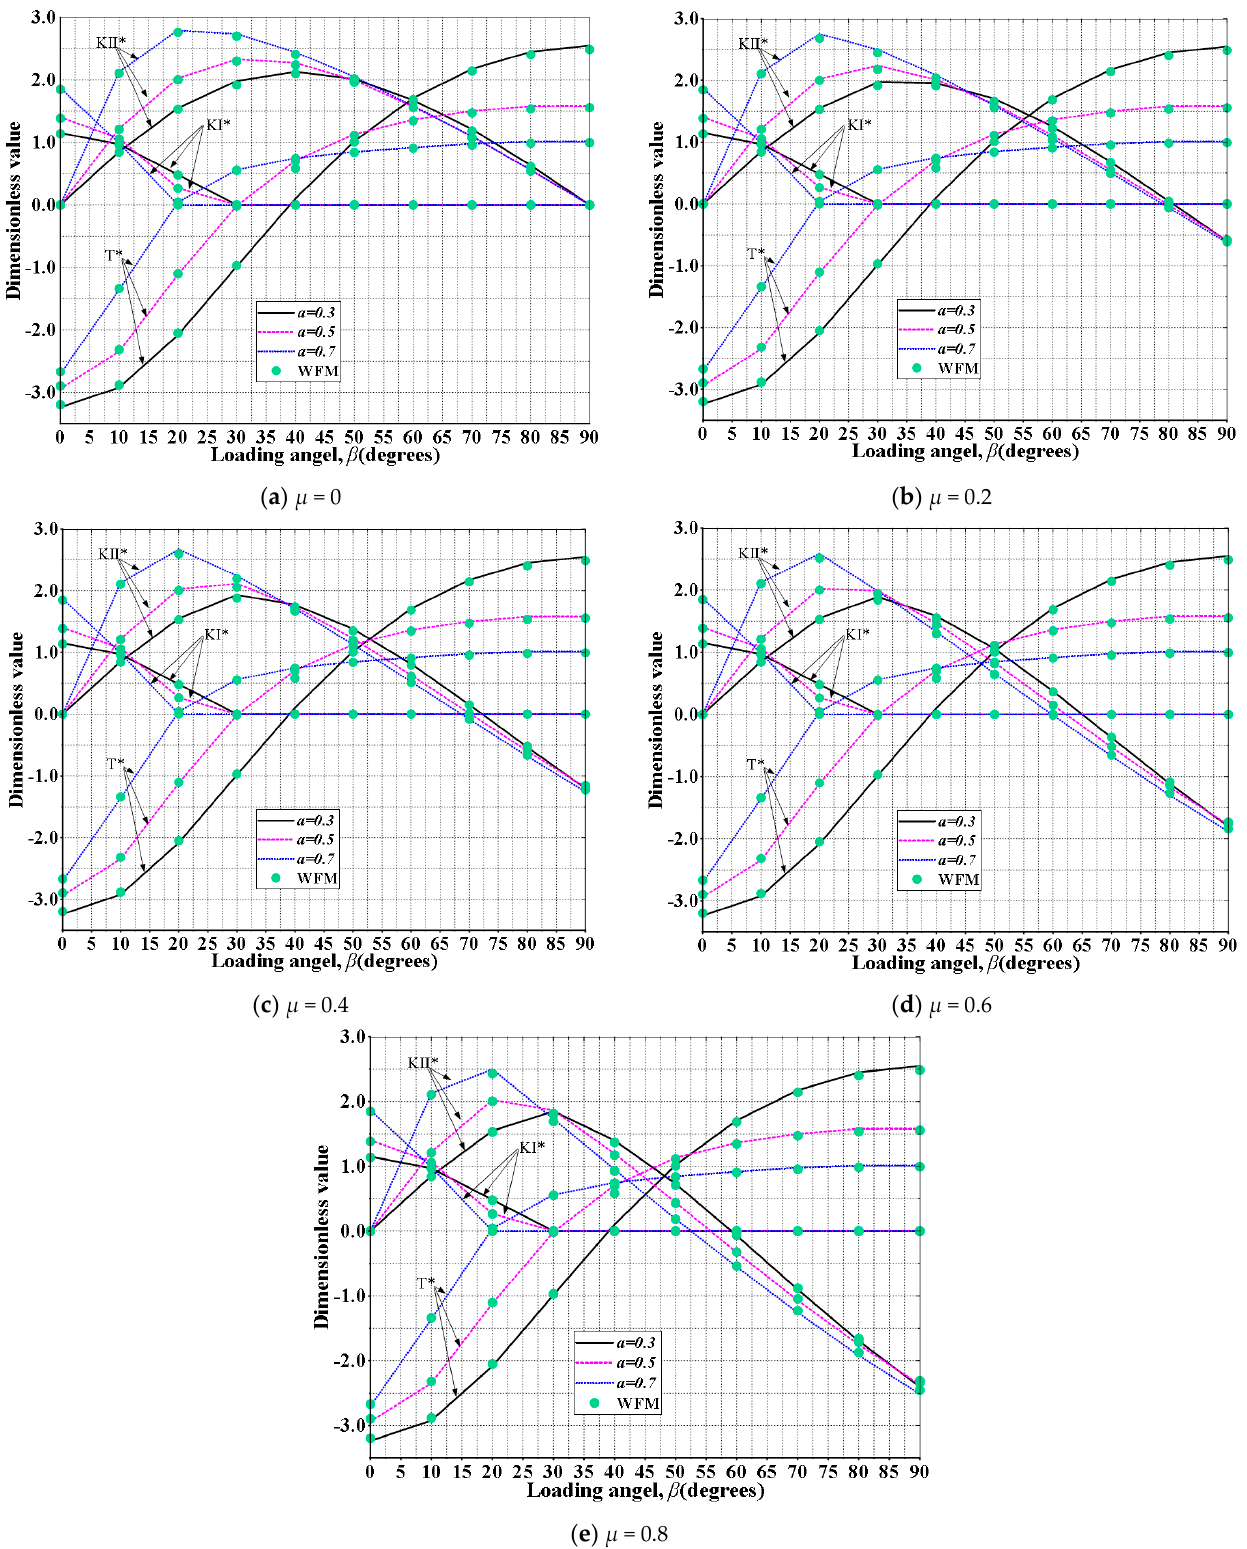
Figure 6. The normalized SIFs and T-stresses for various friction coefficients. ( a ) μ = 0, ( b ) 0.2, ( c ) 0.4, ( d ) 0.6, ( e ) 0.8.